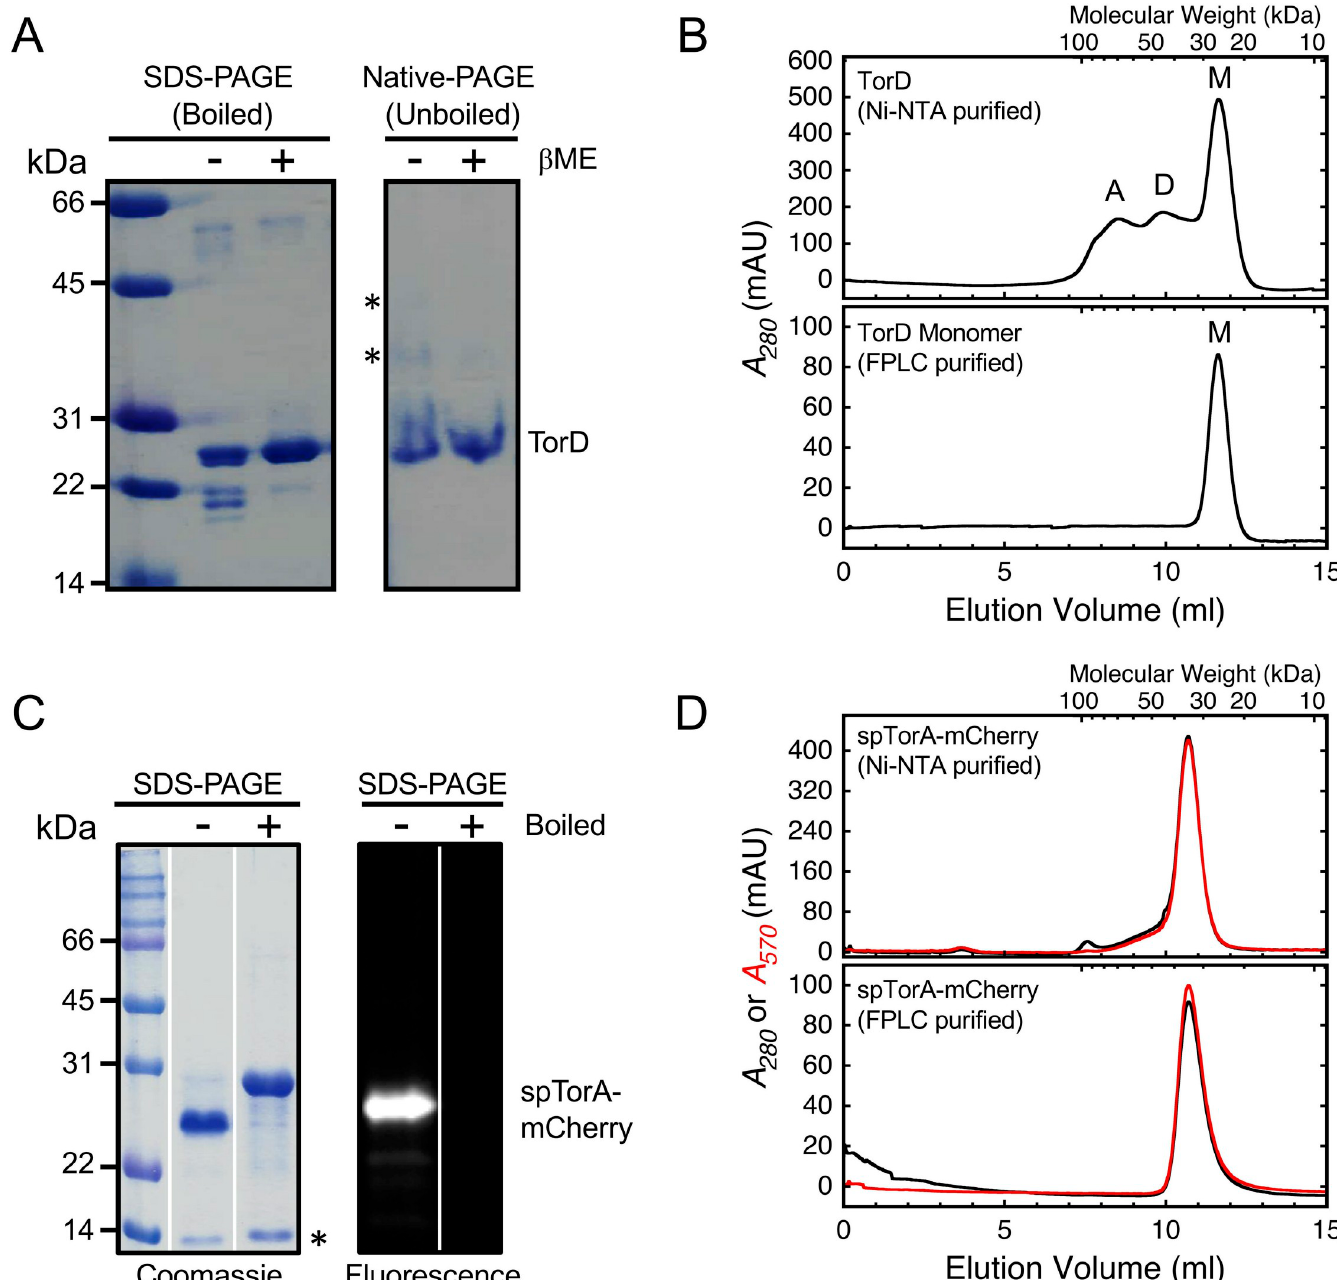
Fig 2. Oligomerization state of TorD and spTorA-mCherry. (A) Oligomerization state of Ni-NTA purified TorD under native gel conditions. TorD is largely monomeric (~17 μ M load), although some higher order oligomers (starred bands) are eliminated by β ME (143 mM) and hence are disulfide-linked. (B) Oligomerization state of TorD analyzed by size-exclusion chromatography. Ni-NTA purified TorD contains higher order oligomers at high concentration ( top , ~170 μ M total load), yet the monomeric form in the FPLC-purified fractions was stable for at least a month at -80˚C when preserved in the presence of 50% glycerol and 5 mM DTT at a lower concentration ( bottom , ~7.0 μ M load). (C) Ni-NTA purified spTorA-mCherry. The fully denatured unfolded form of mCherry (boiled sample) runs slower on SDS-PAGE and is non-fluorescent. The starred ( � ) band is a heat-dependent cleavage product of mCherry [60]. (D) Oligomerization state of spTorA- mCherry analyzed by size-exclusion chromatography. The Ni-NTA purified spTorA-mCherry is largely monomeric ( top , ~290 μ M total load), and remains stably monomeric upon re-chromatographing ( bottom , ~7.1 μ M total load). The molecular weight axis on the top of the size-exclusion chromatograms was generated by a standard curve from the peak elution positions of conalbumin (75 kDa), carbonic anhydrase (29 kDa), RNase (13.7 kDa), and aproptinin (6.5 kDa). The ordinates are milli-absorbance units (mAU).